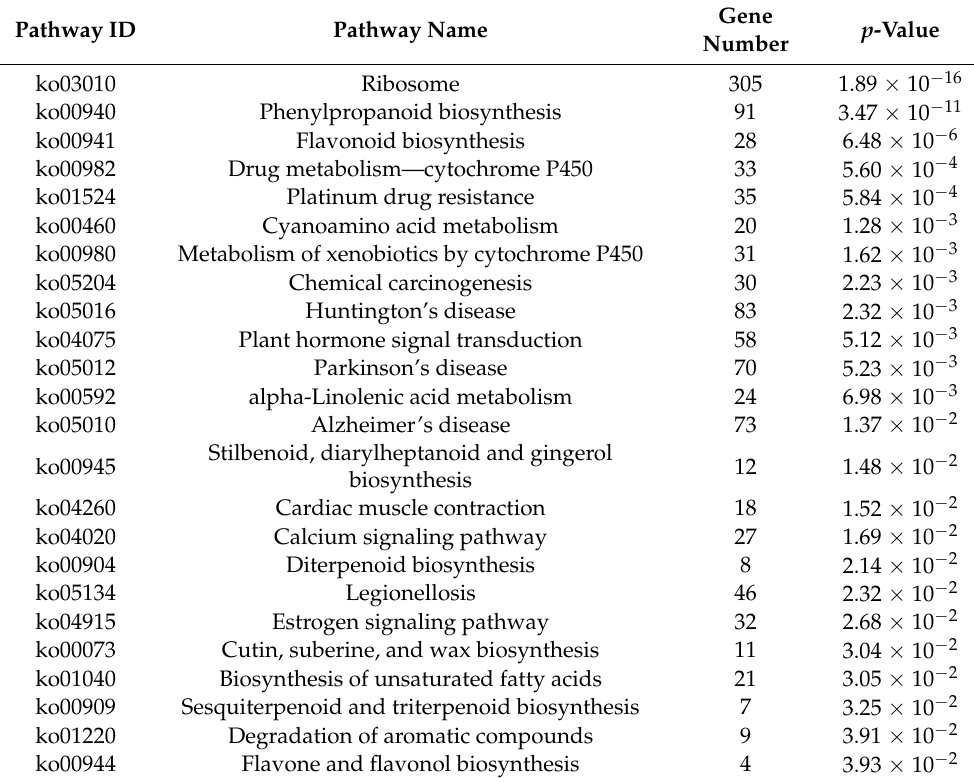
Table 2. KEGG pathway enrichment analysis of DEGs in seashore paspalum.